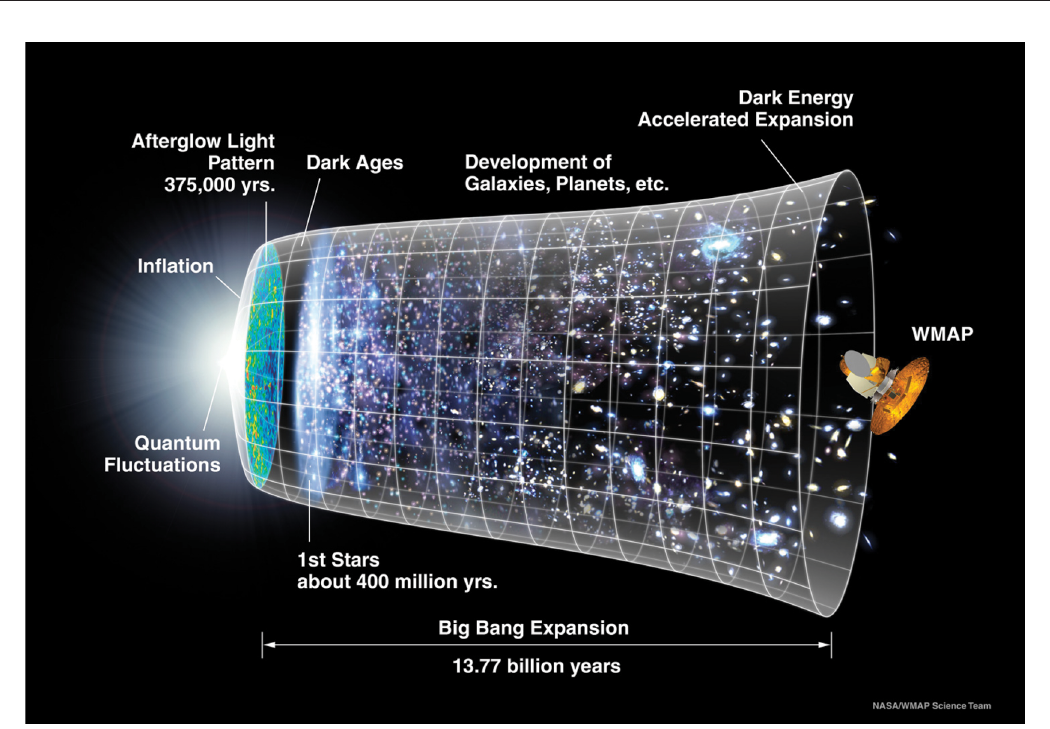
FIG. 16. The timeline of the evolution of the Universe, focusing on the cosmic microwave background and the WMAP satellite which made measurements of the cosmic microwave background. Image credit: